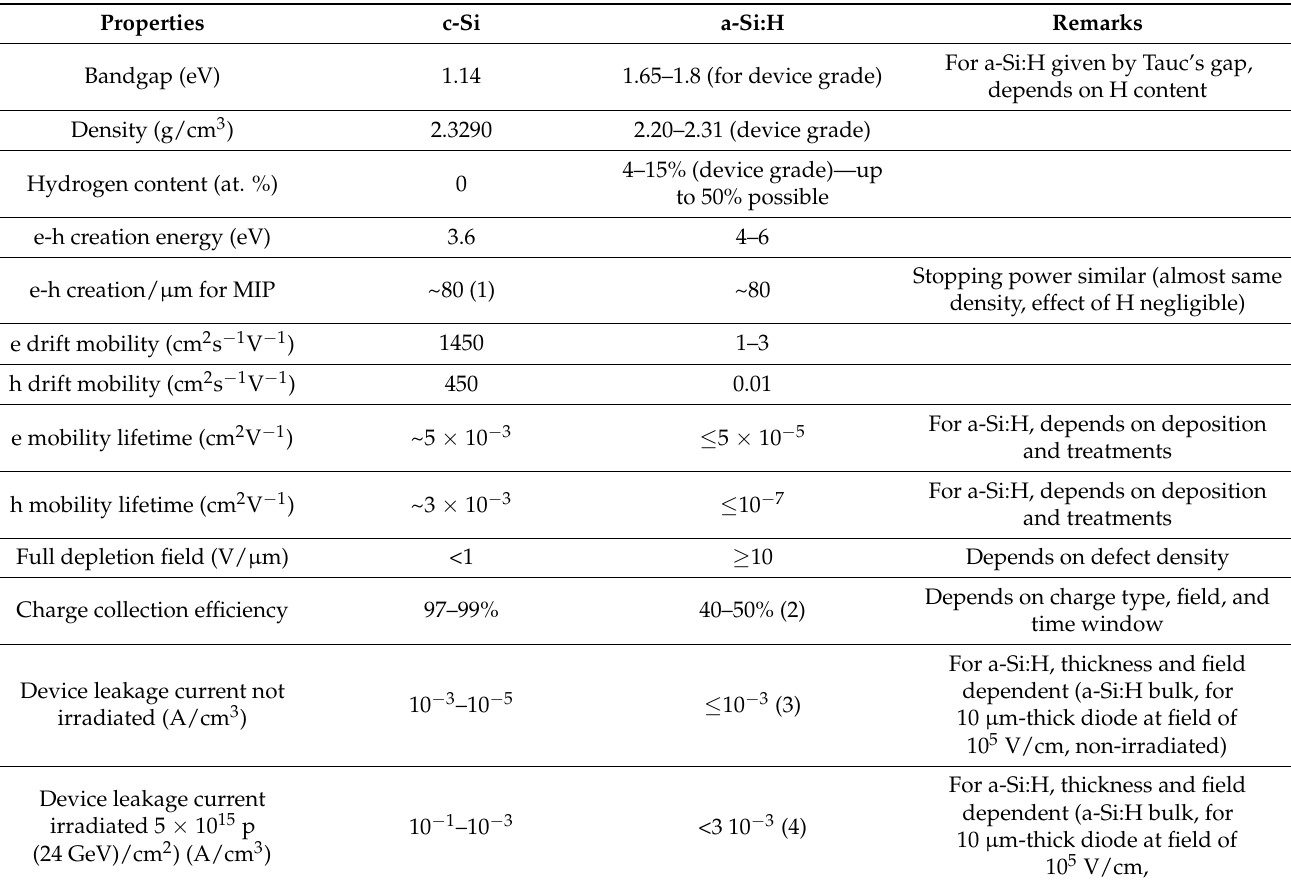
Figure 2. 3D a-Si:H detector configurations: ( a ) finger-type n-doped electrode surrounded by 4 finger- type p-doped electrodes, ( b ) finger-type n-doped electrode surrounded by 8 finger-type p-doped electrodes, ( c ) finger-type n-doped electrode surrounded by 4 trench-type p-doped electrodes, ( d ) all trench configurations. Table 1. Summary of c-Si and a-Si:H characteristics.